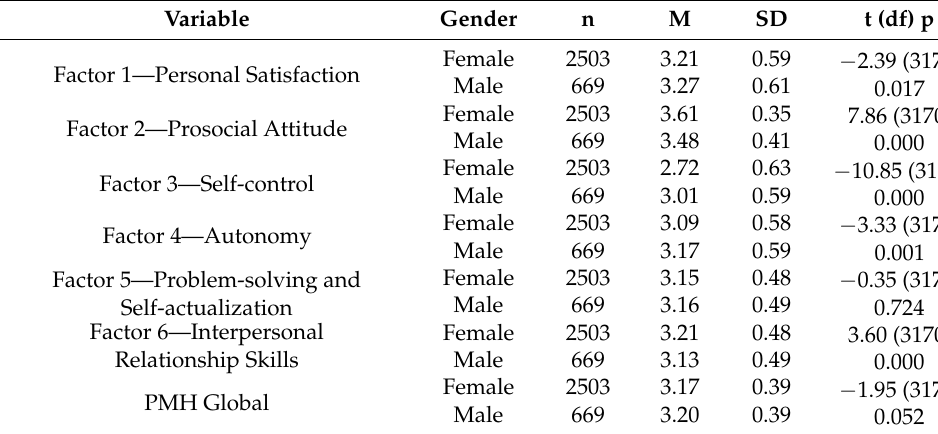
Table 7. Student’s t -test to assess gender and PMH.